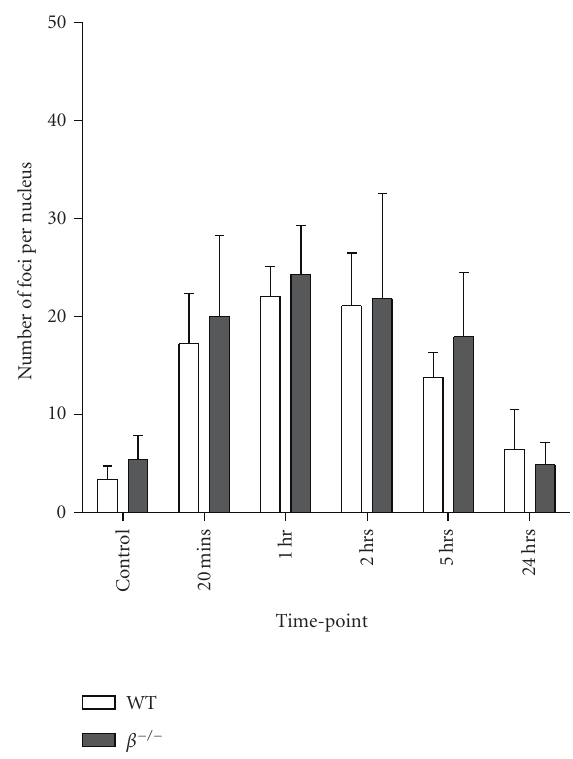
Figure 3: γ H2AX foci following a 2 hour short-term exposure to etoposide. WT and TOP2 β − / − MEFs were exposed to 1 μ M etoposide and γ H2AX foci were counted at the indicated time points after drug removal. The data are derived from at least n = 3 independent experiments, each data point shows the mean ±